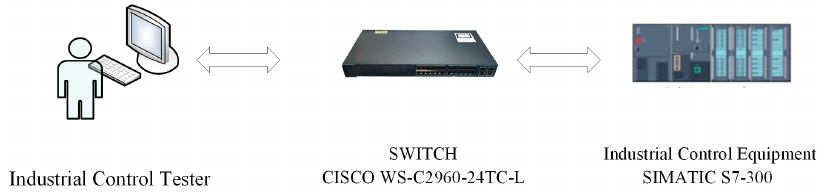
Figure 8. Experimental environment for vulnerability mining of Modbus TCP .